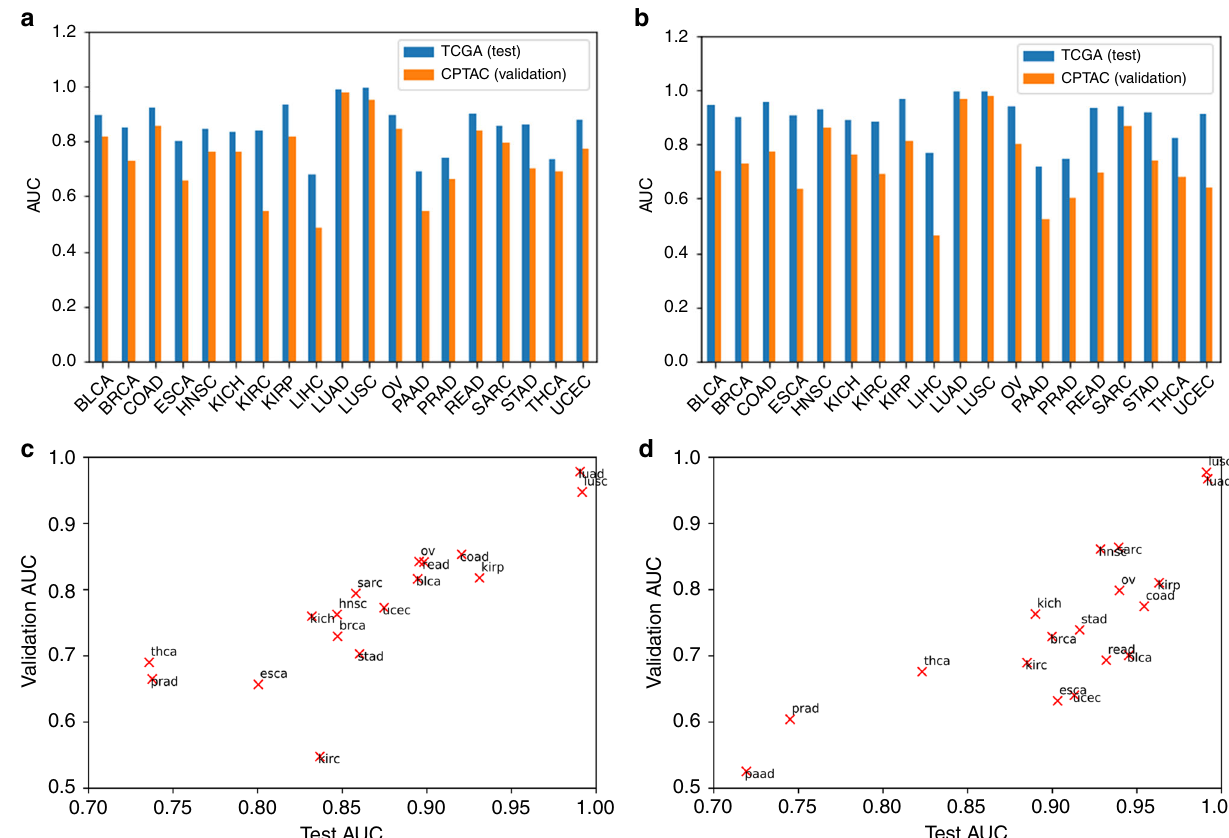
Fig. 6 AUC of tumor-normal classi fi ers on the TCGA test set and CPTAC validation set for LUAD and LUSC cancers. Classi fi cation AUCs of each TCGA- trained tumor/normal classi fi er applied to LUAD and LUSC images from TCGA (reserved “ test ” data) and CPTAC (external “ validation ” data, LUAD: n = 1055, LUSC: n = 1060) are shown. a Bar graphs comparing test and validation AUCs on LUAD and b LUSC slides. c Scatter plot of test AUC versus validation AUC for LUAD and d LUSC. TCGA train and test sample sizes are provided in Fig. 2a.